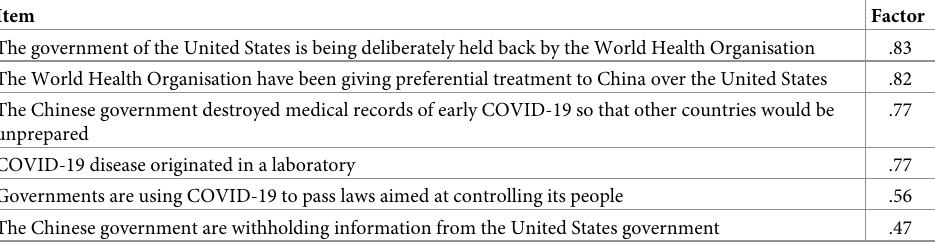
Table 4. Item loadings for a forced single-factor model for COVID-19 conspiracy theories using Principal Axis Factoring.